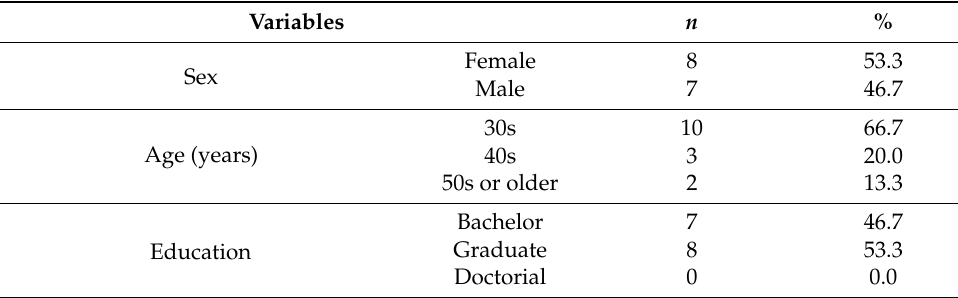
Table 8. Interview participants’ personal and professional